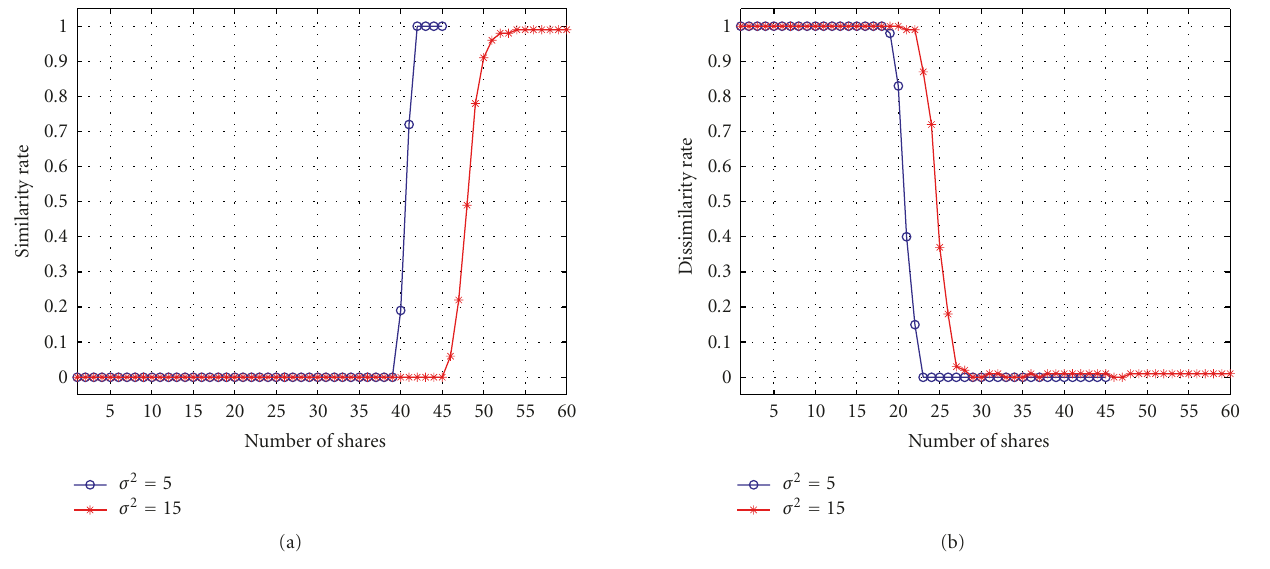
Figure 5: (a) Similarity rate; (b) dissimilarity